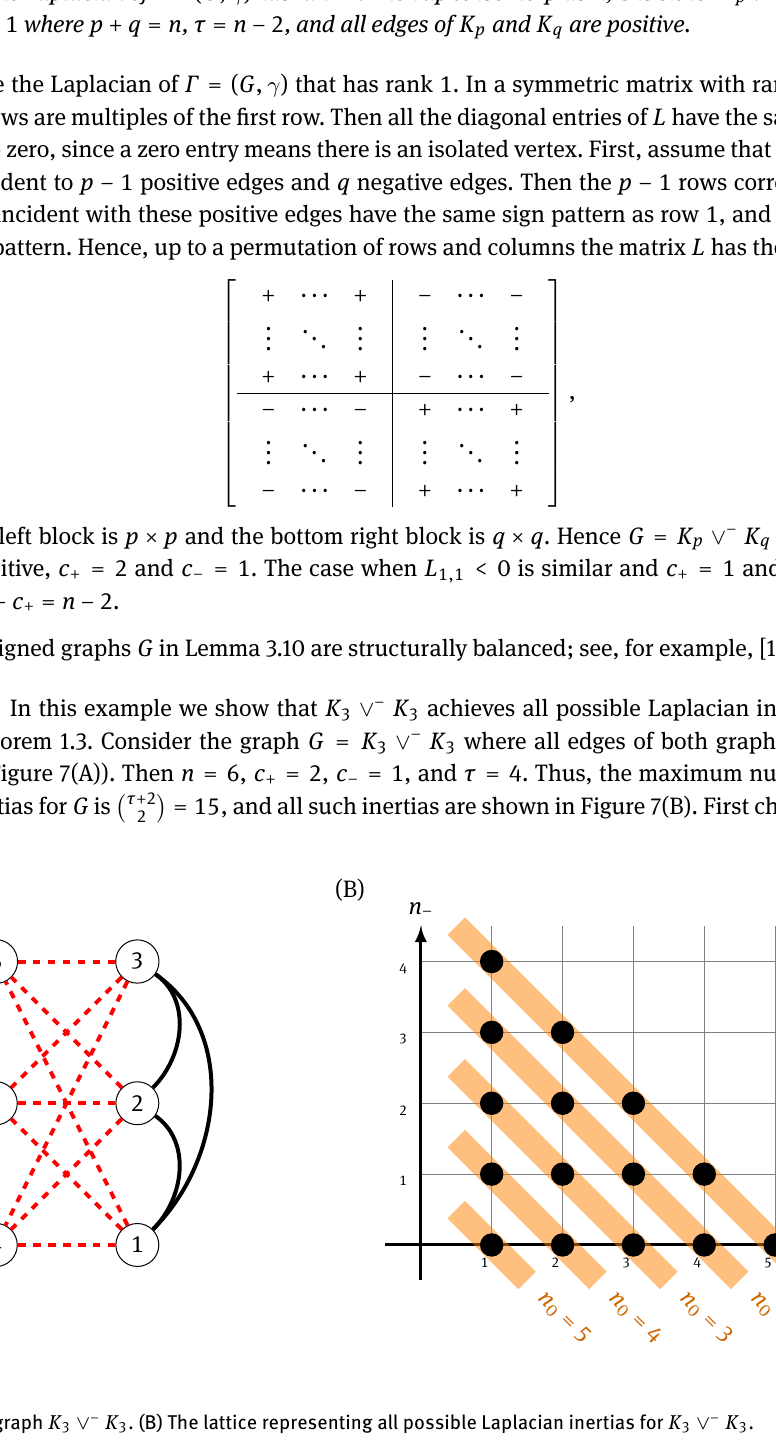
and one of the positive edges on the other K 3